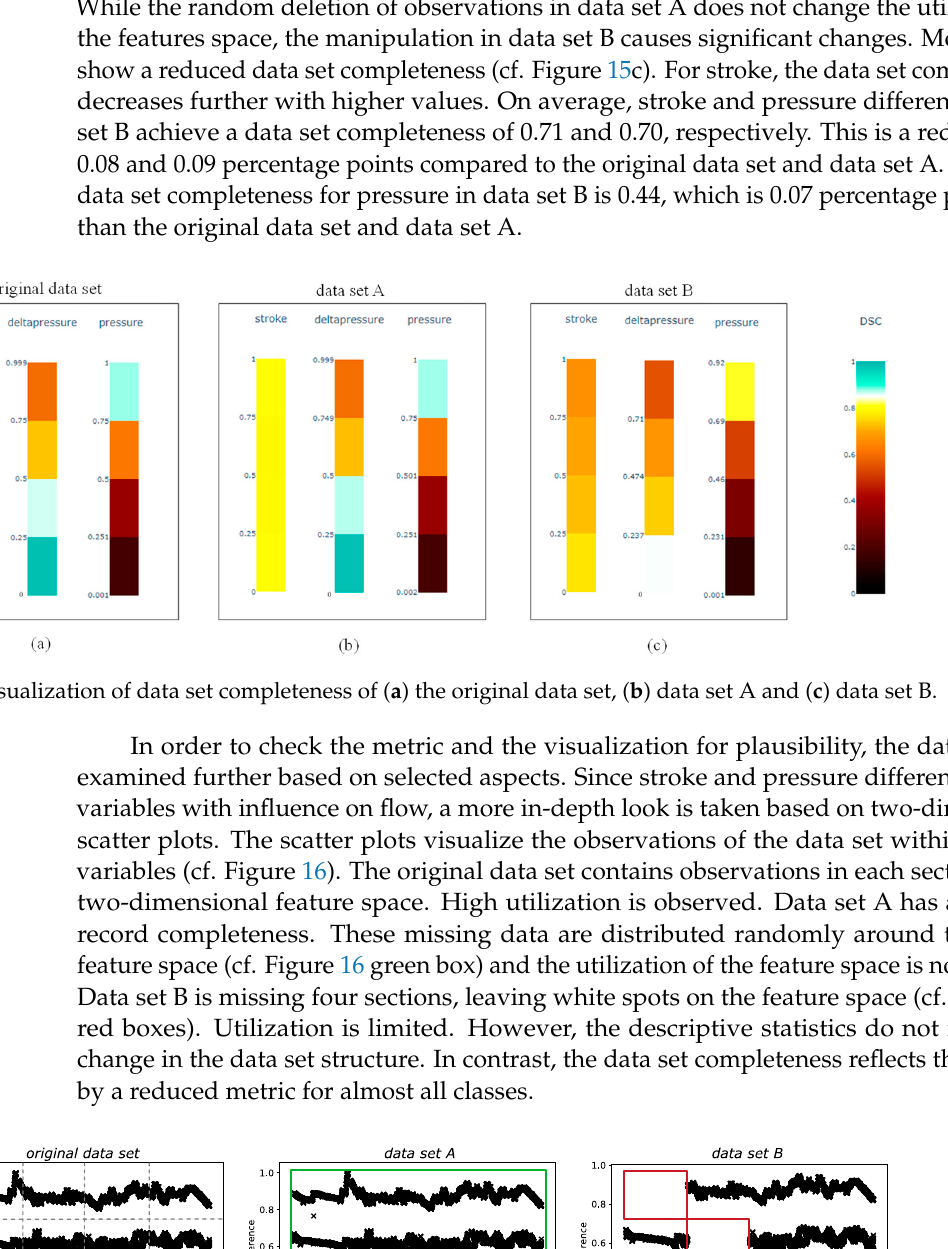
Table 3. Coefficient of determination and RMSE of the random forest regression of the original data set, data set A and B. Figure 16. Scatter plots of stroke and pressure difference for the original data set ( left ), data set A with random deletion of observations ( center ) and data set B with deletion of observations in distinct sections ( right ).